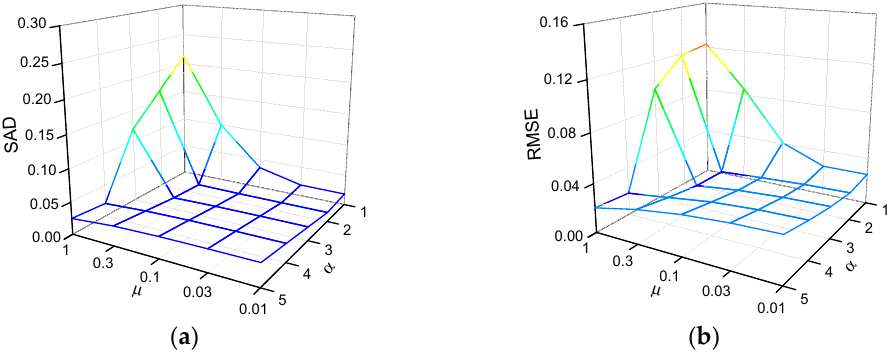
Figure 3. The experimental results for different parameters: ( a ) spectral angle distance (SAD) and ( b ) root mean square error (RMSE).